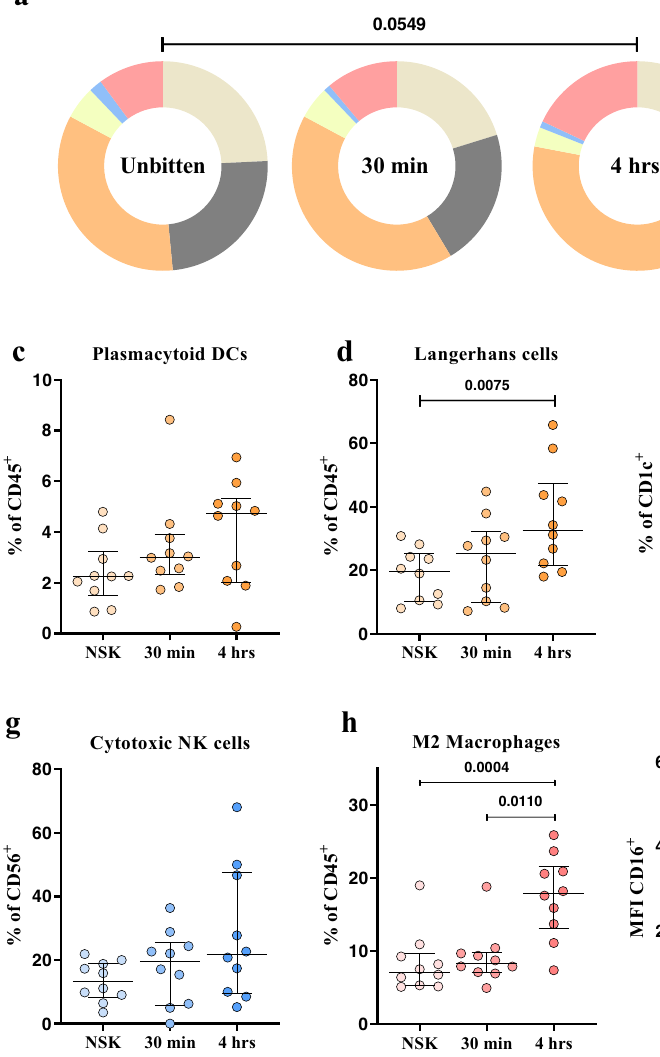
mosquito bites. e Frequency of activated dermal DCs (CD1c + CD69 + ) from the total dermal DCs population (CD1 + ). f Frequency of NK cells (CD56) reported as per- centage of total CD45 + cells. g Frequency of cytotoxic NK cells (CD56 + CD16 + ) as percentage of total NK cells. h – j Frequency of M2 macrophages and MFI of their expressed activation markers CD16 and CD69. Statistical analyses were performed with Chi-square test, two tailed ( a ) and Friedman+Dunn ’ s multiple comparisons test, two tailed with adjusted p -values reported ( b – j ). Bars indicate median and interquartile range. N =10 individuals. Only p -values<0.05 are reported. Source data are provided as a Source Data fi